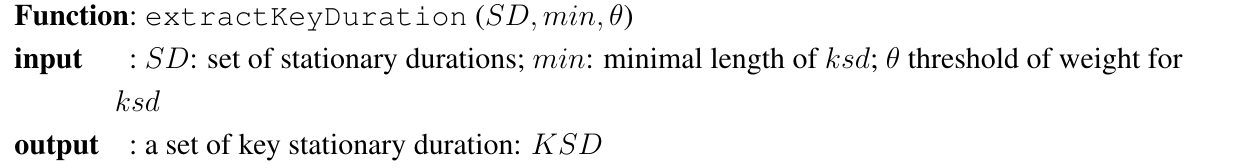
Algorithm A1 : Key stationary duration